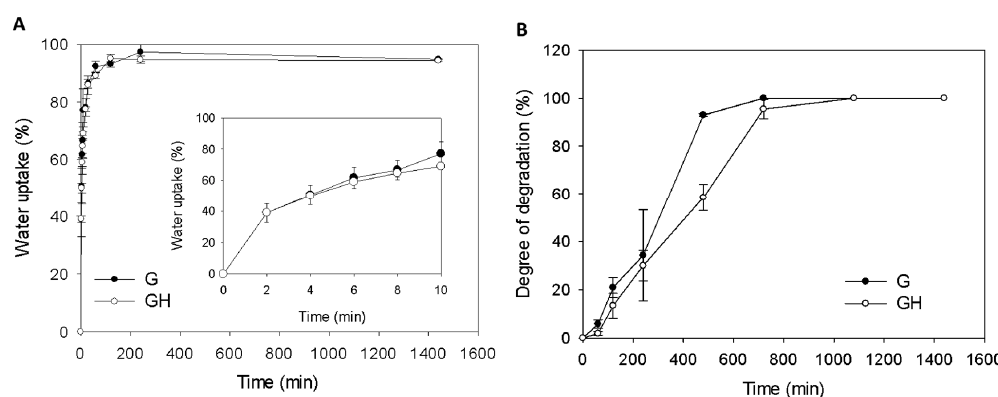
Figure 2. The water uptake kinetics in phosphate bu ff ered saline (PBS) ( A ) and degradation kinetics in collagenase ( B ) of G and GH